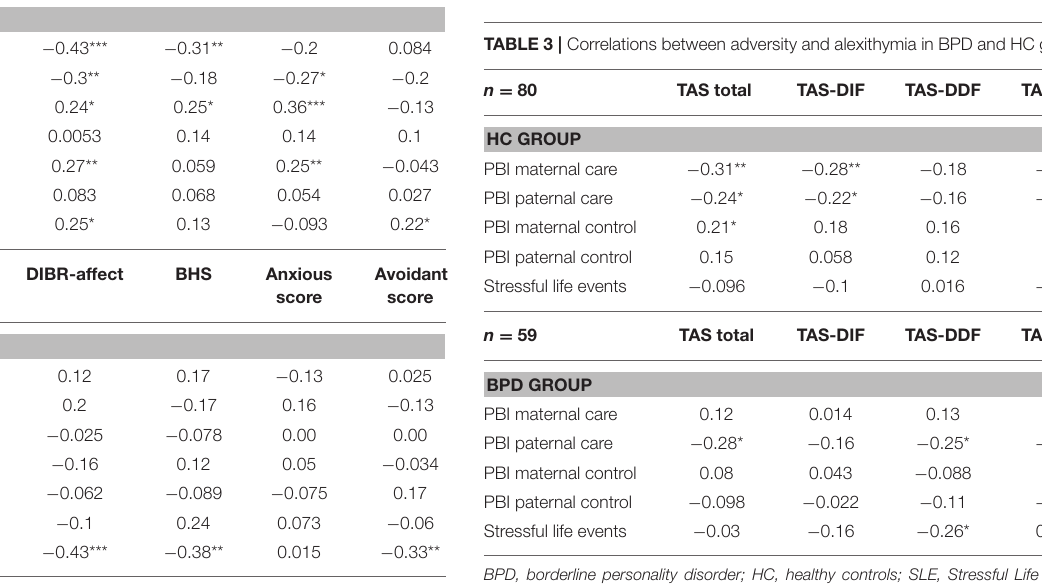
Frontiers in Psychiatry |